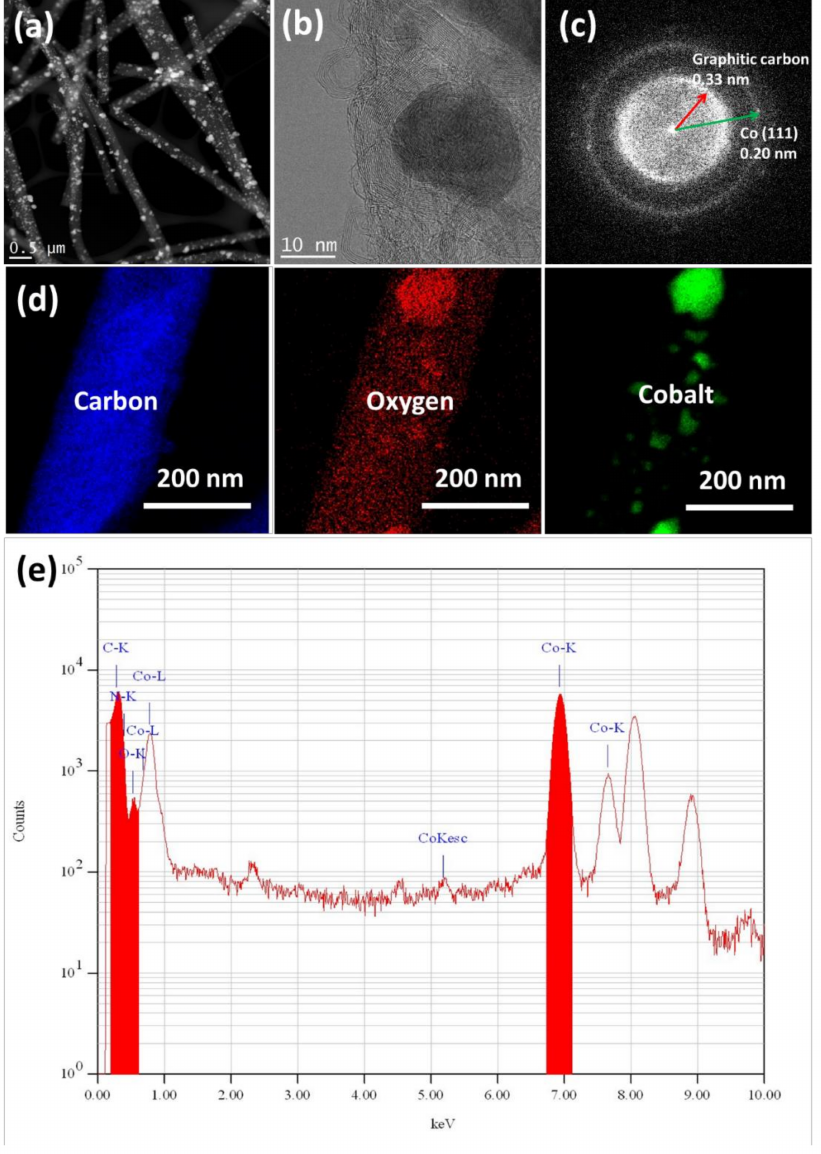
Figure 2. HR-TEM analysis of the CNF-Co20 electrode: ( a ) low magnification and ( b ) high magnification TEM micrographs; ( c ) SAED patterns; ( d ) TEM with elemental mapping; and ( e ) TEM-EDX